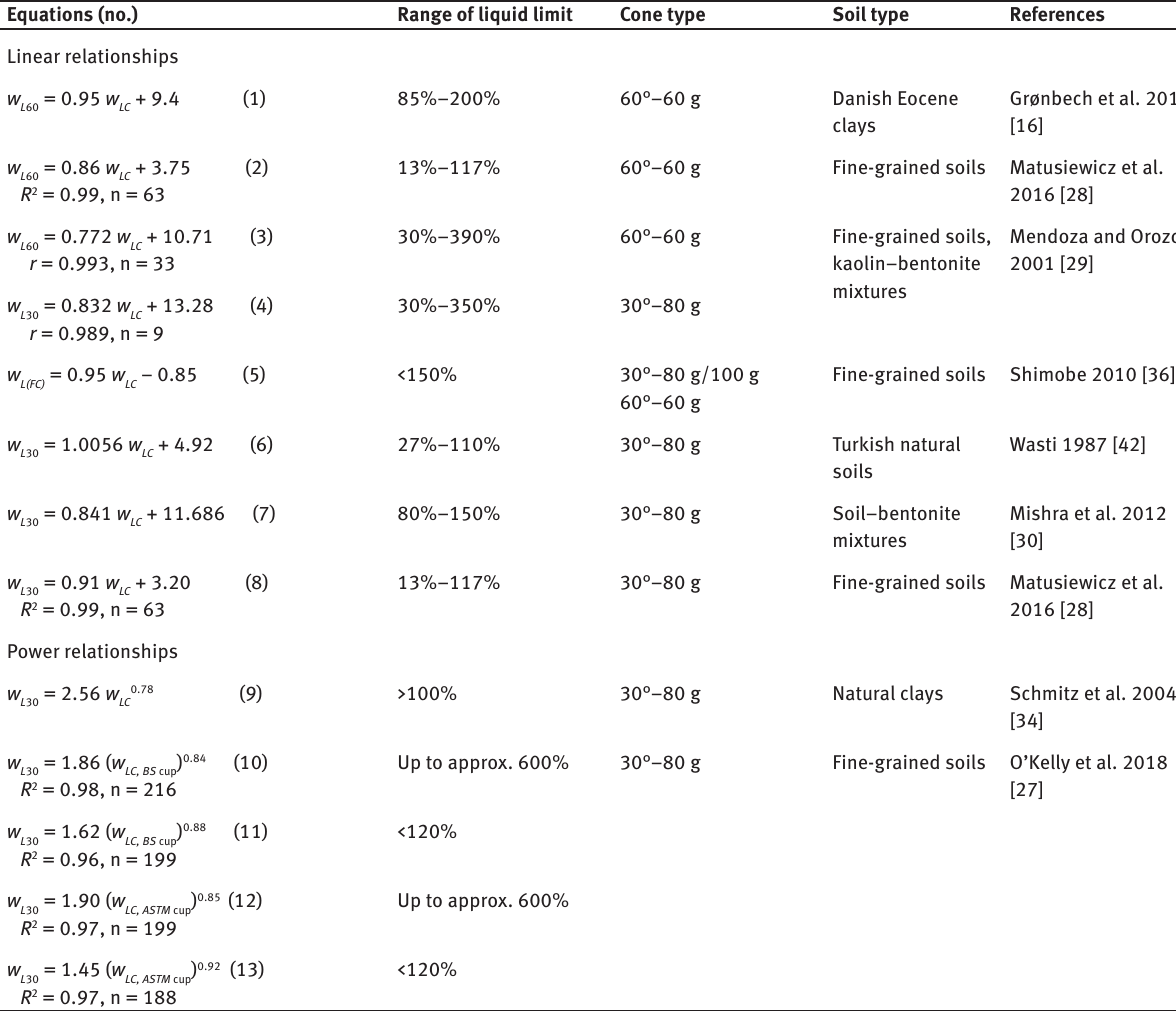
Table 1: Relationships between the fall cone liquid limit and the Casagrande liquid limit for cohesive soils in the literature. Equations